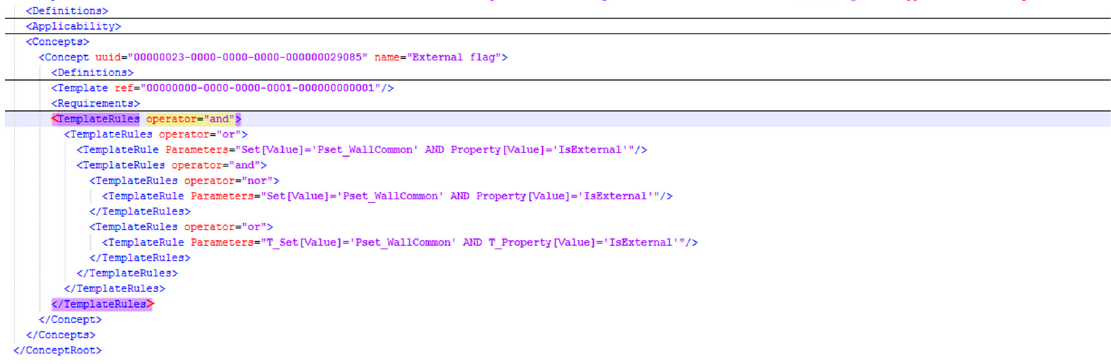
Figure 8. <Requirements> definition example.